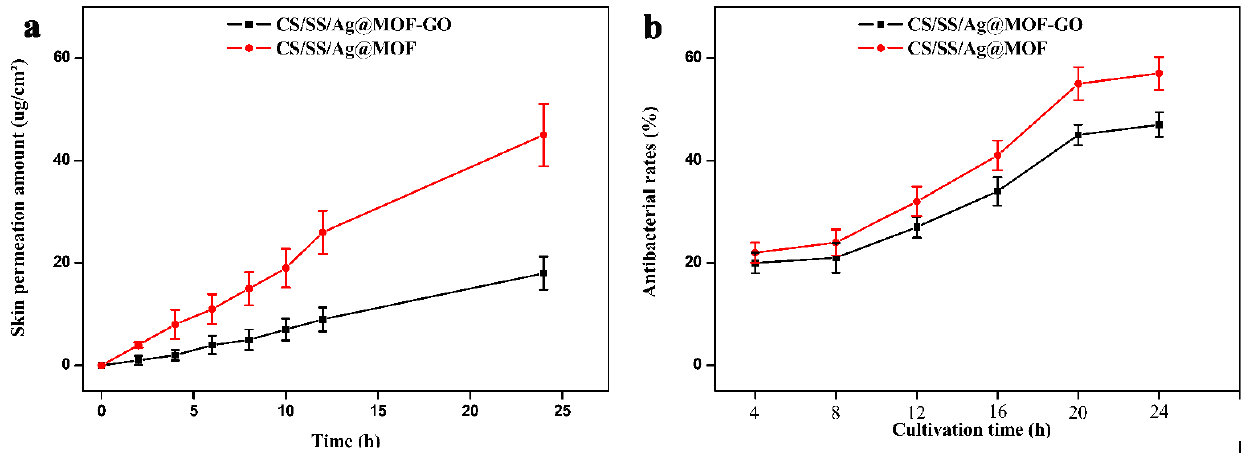
Figure 7. ( a ) Cumulative skin permeation profiles of Ag. ( b ) Antibacterial rates of the extracts of Ti–Ag samples.